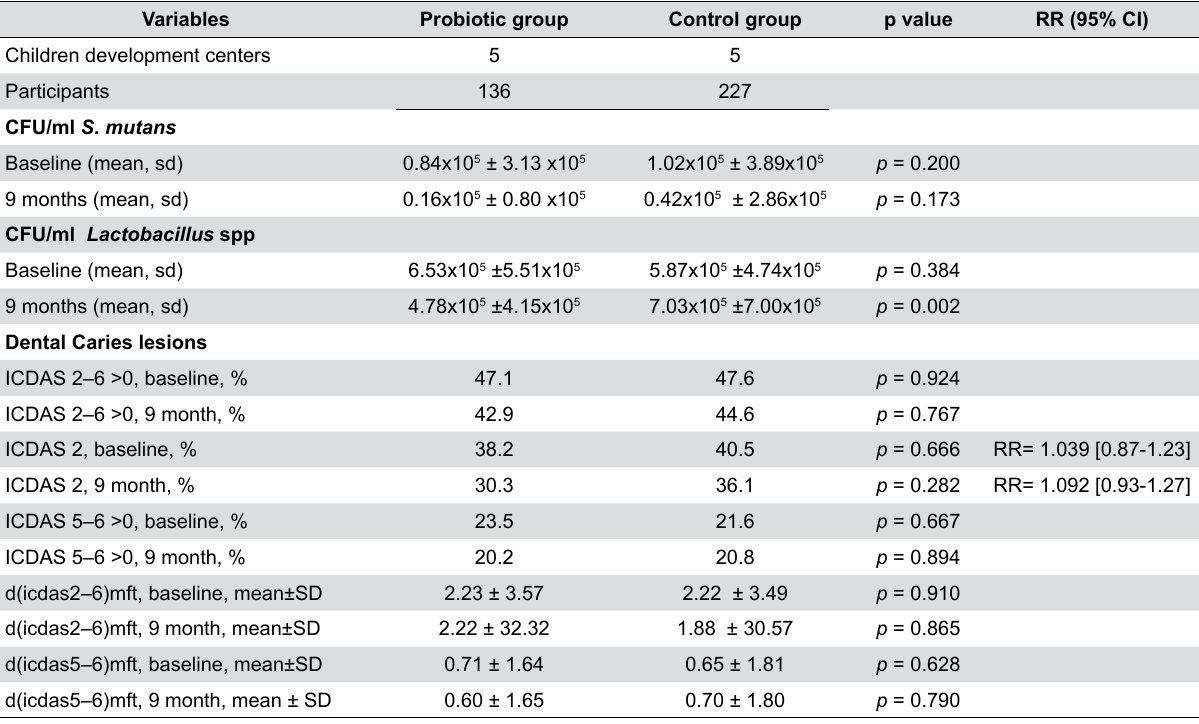
Table 2- S. mutans , Lactobacillus spp., dental caries in the probiotic group and control group at baseline and at 9 months of